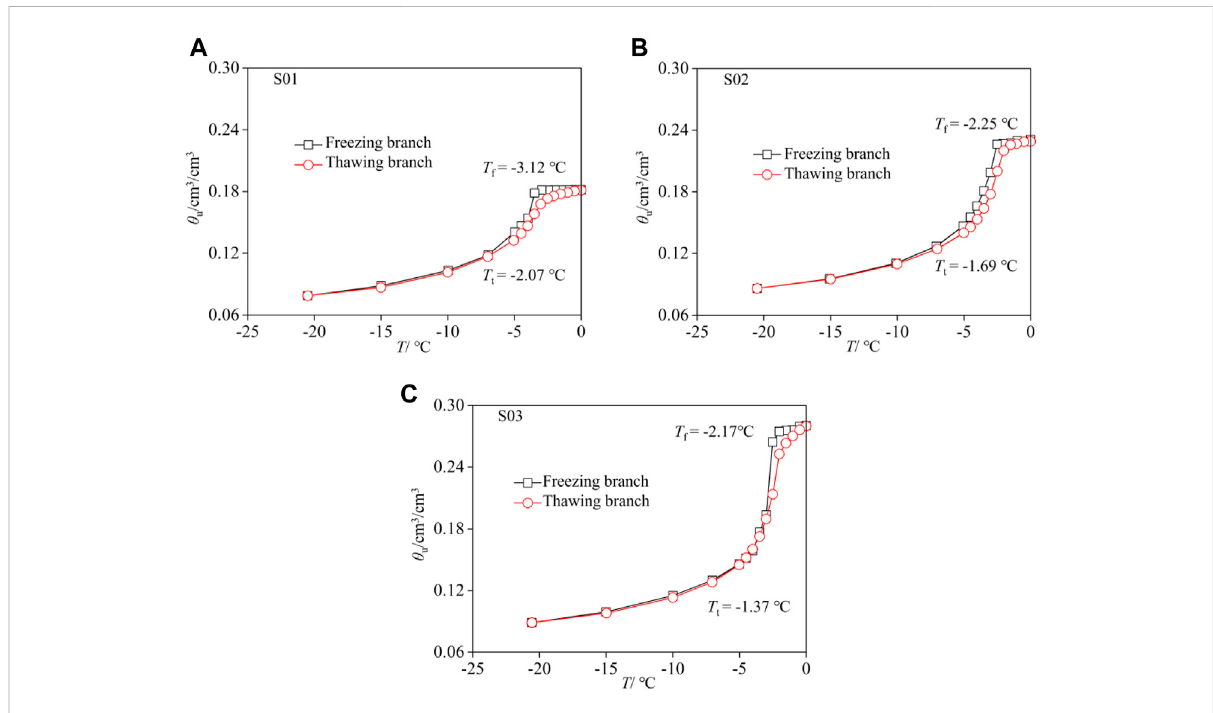
FIGURE 3 Effect of initial water content on the